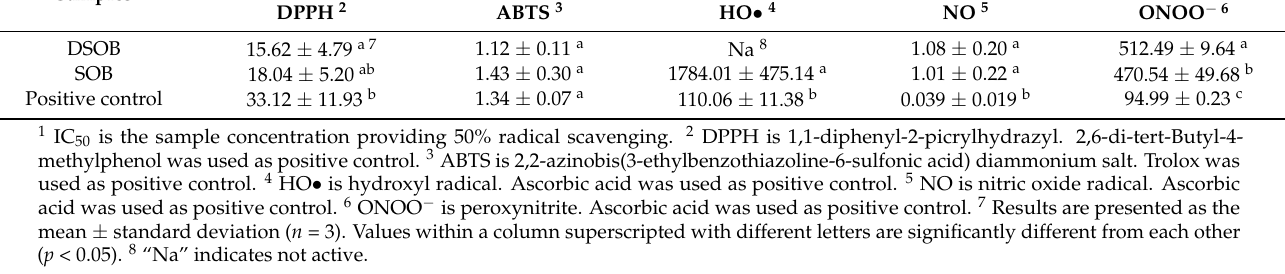
Table 2. IC 50 of defatted seeds of Oenothera biennis (DSOB) and seeds of Oenothera biennis (SOB) on radical scavenging. Samples